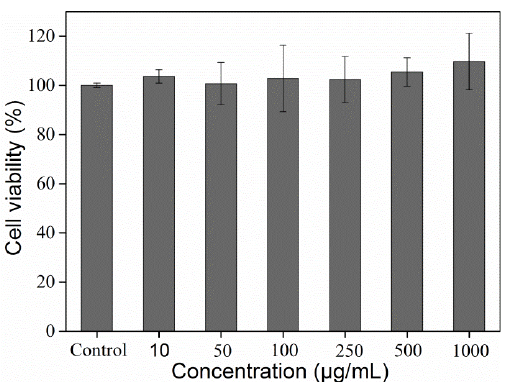
Figure 7. The cell viability as the function of the concentration of Se-starch80.